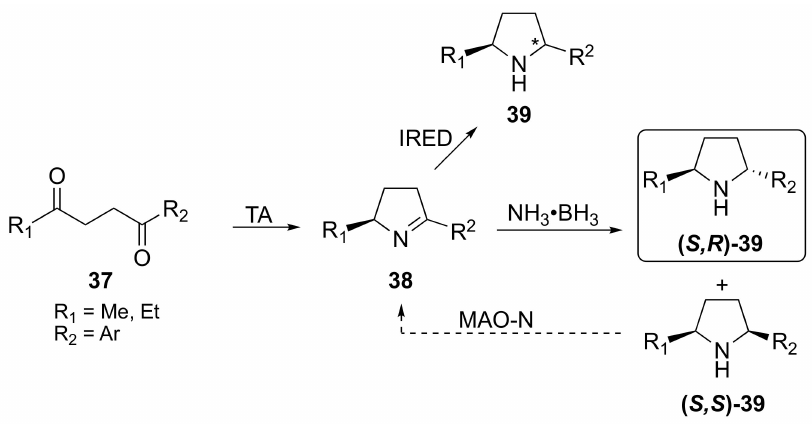
Figure 8. TA-mediated synthesis of pyrrolidine derivatives from diketones.